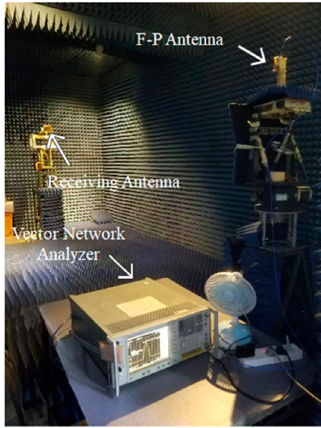
Figure 18. Testing diagram.